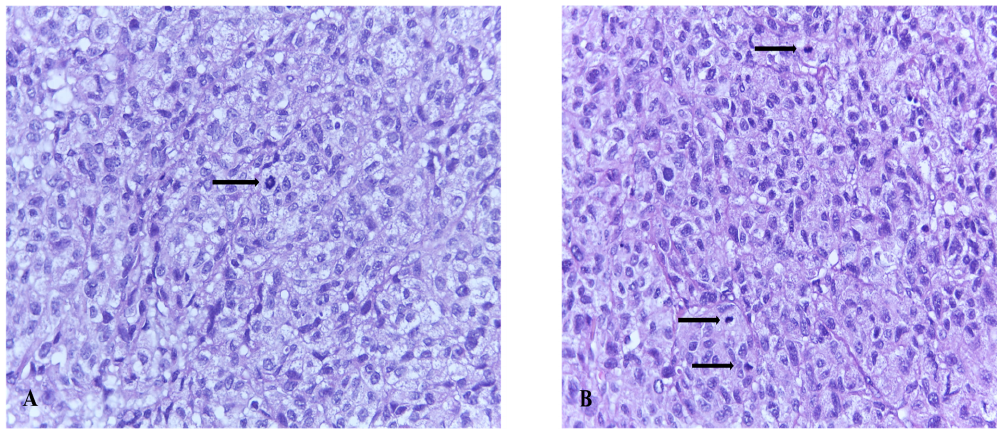
Figure 5. ( A ) Vaginal melanoma. Tumoral cells filled with melanin organized in nests at the epithelium-lamina propria junction—pathognomonic for the diagnosis, original magnification × 20. ( B ) Detail showing haphazardly distributed atypical melanocytes in lamina propria original magnification × 40 Hematoxylin-eosin stain (histological image courtesy of dr. Ileana Popa).